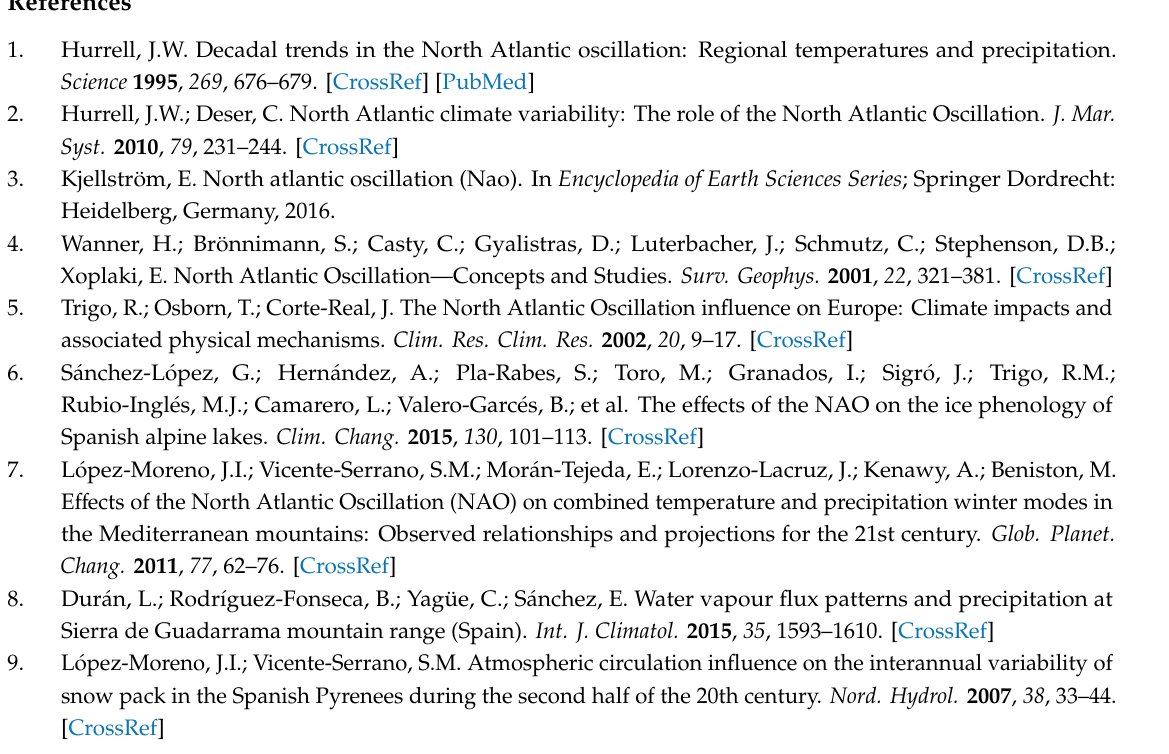
Figure S1: Pearson’s R values between the DJFM-NAO and the peak SWE. The lines represent the boundaries of the main catchments in the Iberian